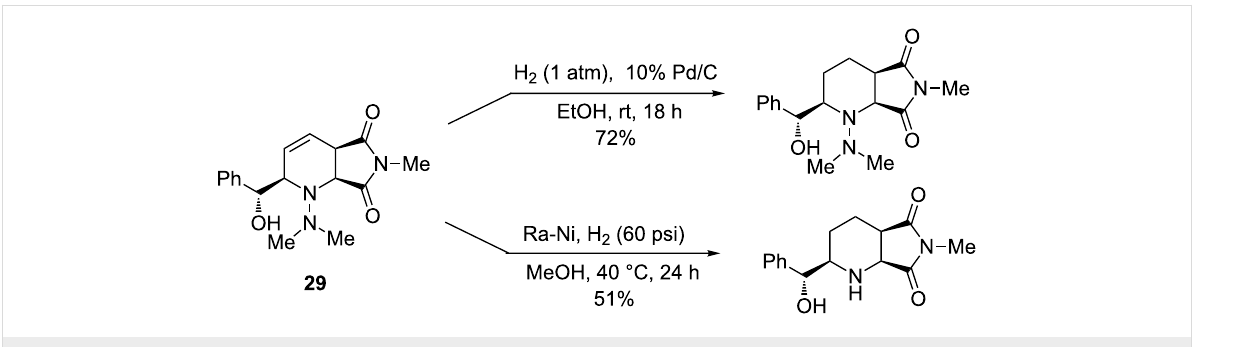
Scheme 22: Hydrogenolysis reactions of